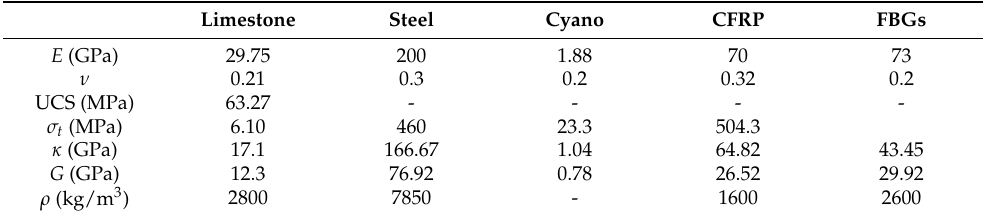
Table 5. Properties of model